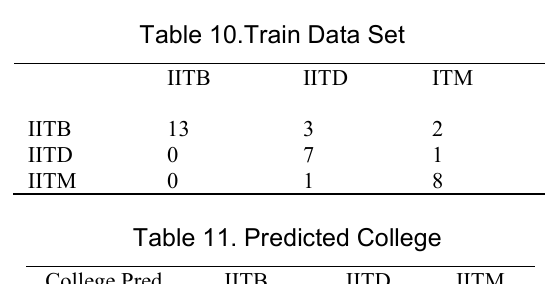
Figure 11. Result of